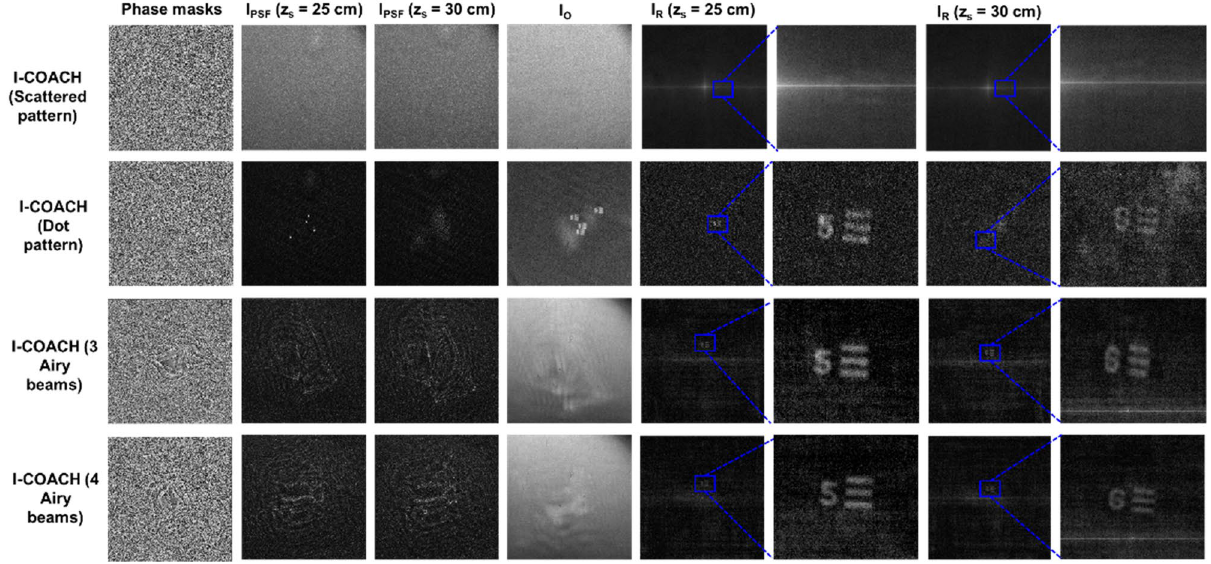
Figure 5. Experimental results of I-COACH with scattered pattern, dot pattern, 3 Airy beams and 4 Airy beams. z s is the distance between the object and the phase modulator; I PSF —point spread function; I O —object intensity distribution; I R —reconstructed